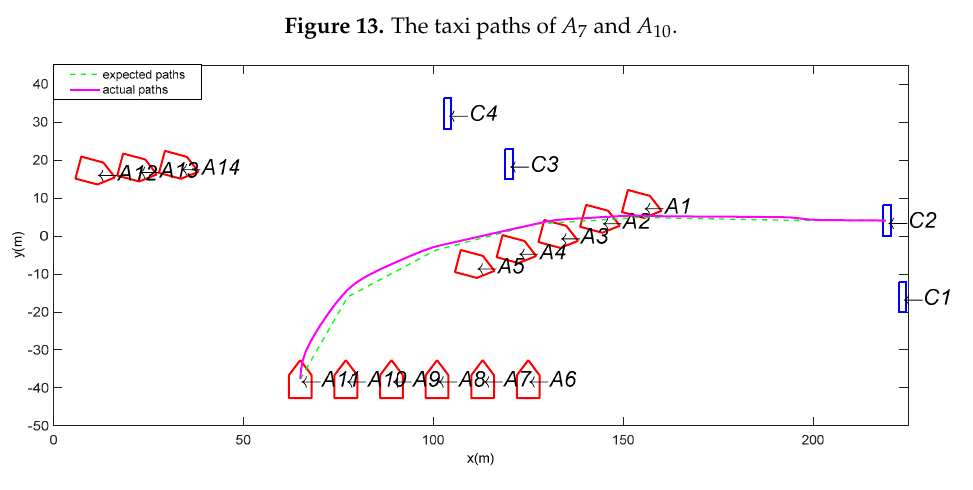
Figure 14. The taxi path of A 11.